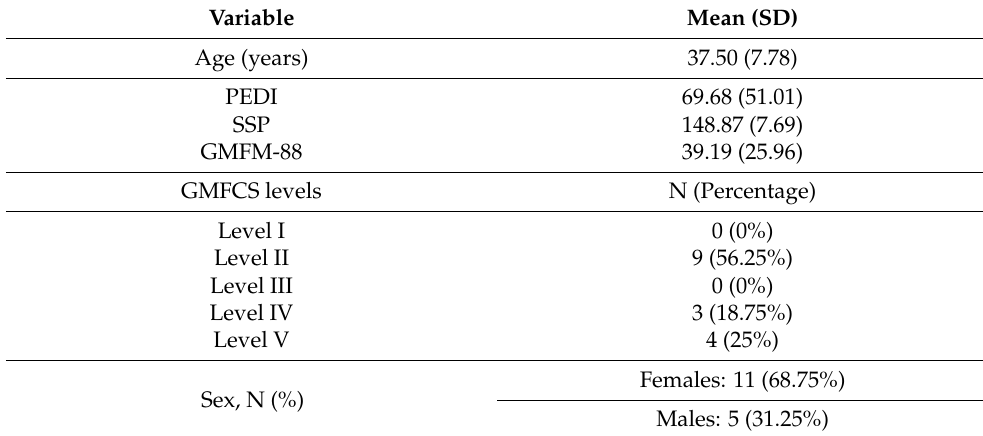
Table 1. Characteristics of